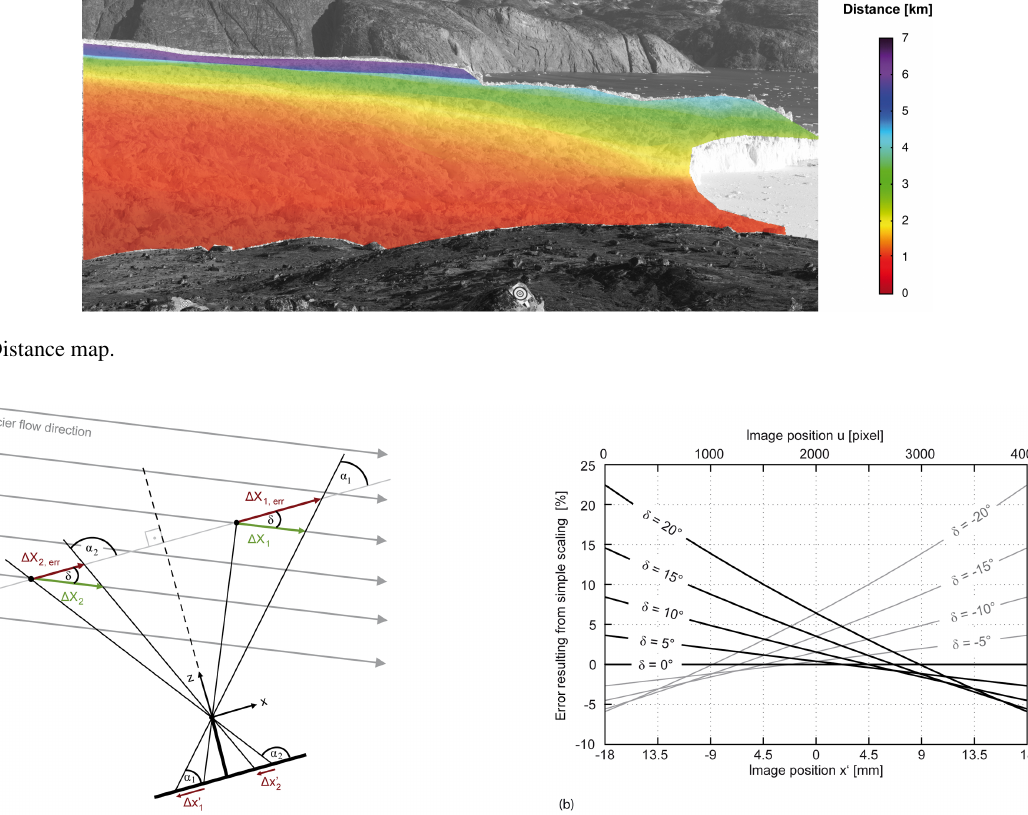
Figure 13. Scaling error in the case of a deviation δ from orthogonality between the glacier flow direction and the viewing direction of the camera (shown for the horizontal motion